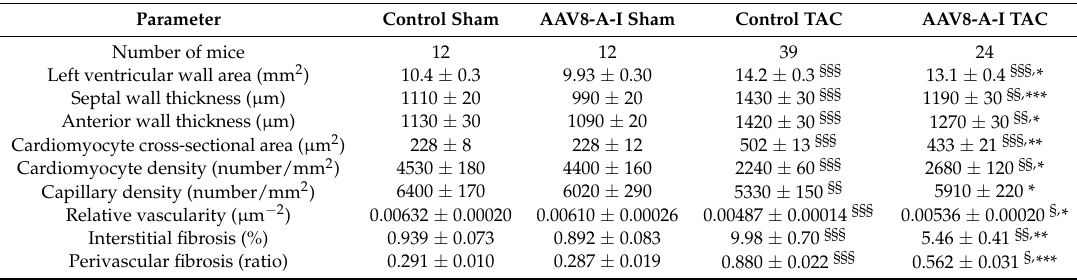
Table 3. Morphometric and histological parameters of the left ventricular myocardium in C57BL/6 LDLr − / − mice.